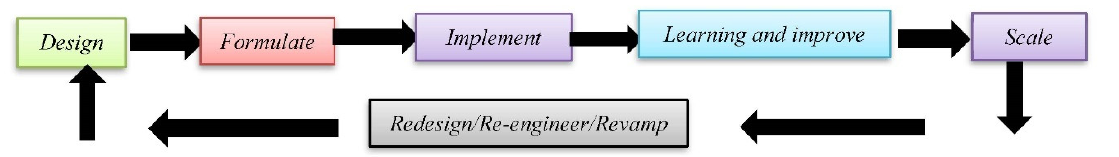
Figure 2. Fundamental model of emergent approach to education strategy. Source: Based on Fixson and Rao (2014).